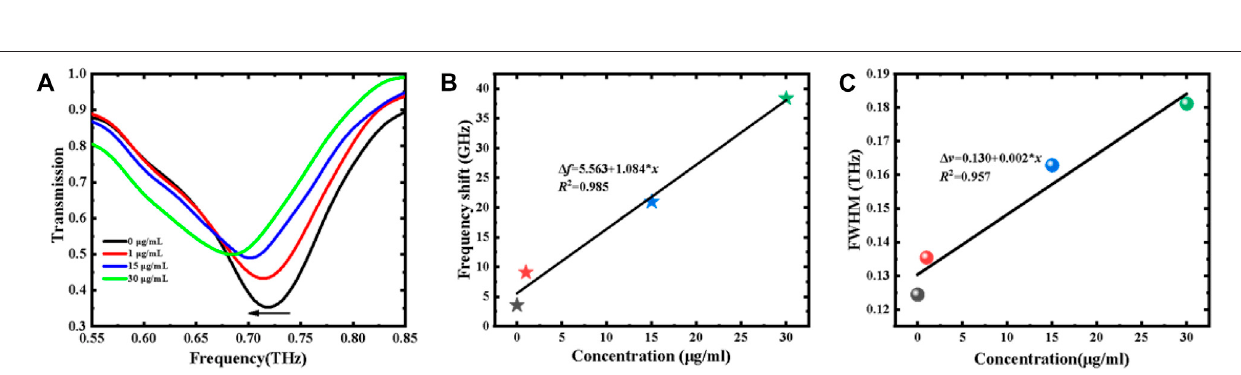
FIGURE 7 | (A) Measured transmission spectra of S1 protein with various concentrations. (B) Resonance frequency shift and (C) FWHM variation vs. concentration.